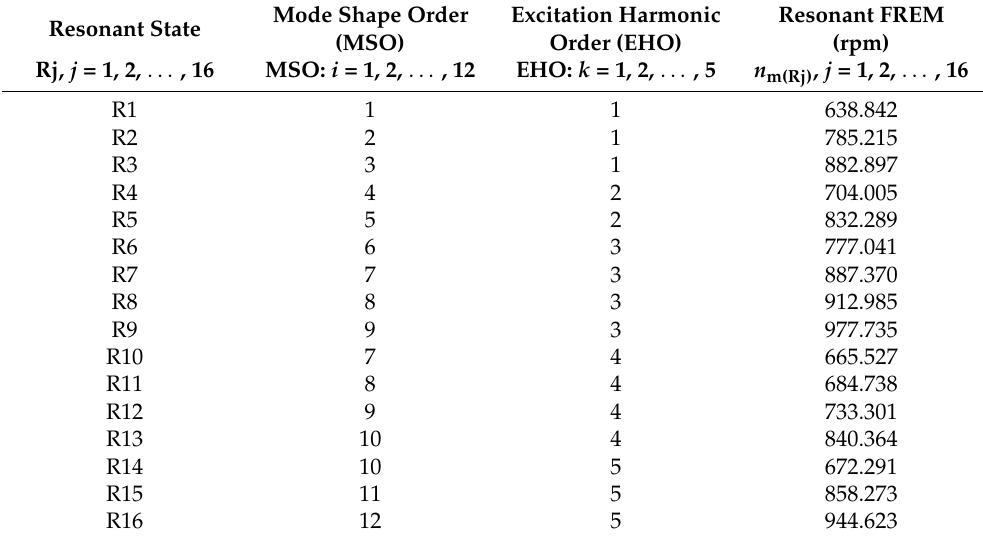
Table 3. The resonant